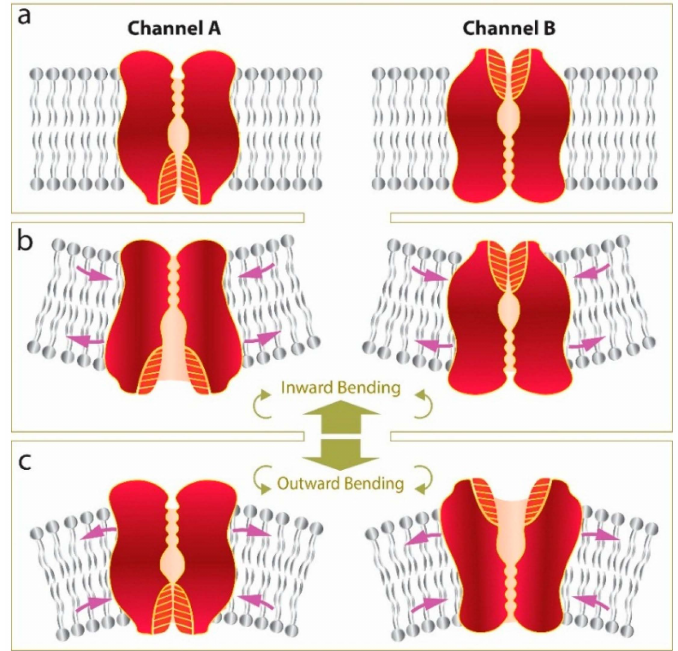
Figure 9. Schematic representation of how local bending can have different effects on gating of structurally different channels (Channel A and Channel B). If we assume both channels are in the closed state ( a ); bending of the membrane in the inward direction ( b ); tends to open Channel A but close Channel B. Conversely, applying local bending in the outward direction ( c ) tends to close Channel A and open Channel